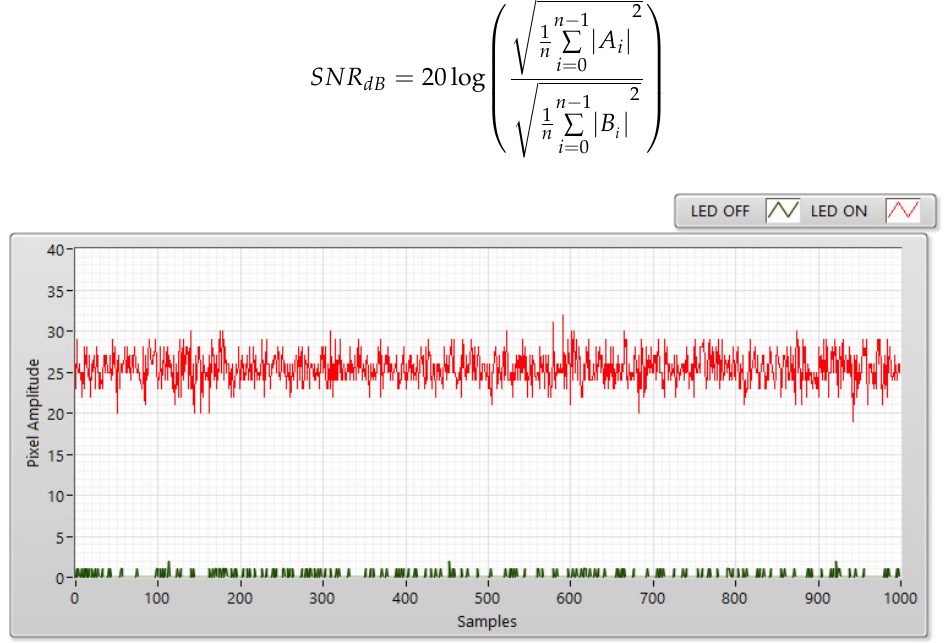
Figure 5. The device for the SNR measurement.